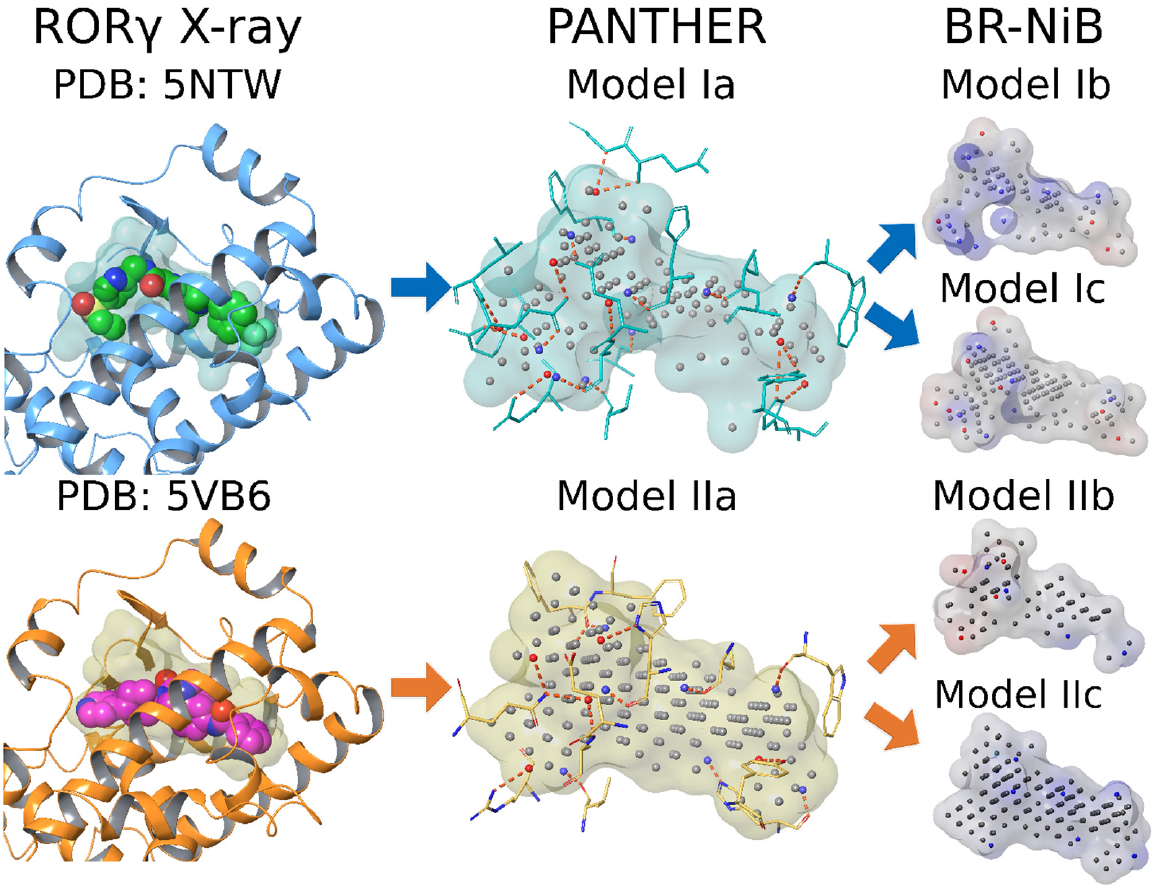
Figure 2. Negative image-based models of the ROR γ t binding cavity. The original cavity-filling negative image-based (NIB) models, Model Ia (PDB: 5NTW [32], cyan transparent surface) and Model IIa (PDB: 5VB6 [42]; yellow transparent surface), were trimmed with brute force negative image-based optimization (BR-NiB) using the complete set of active ligands from the ChEMBL database yielding Models Ib and IIb, respectively. Alternatively, the models were also optimized using only a subset of the ligands yielding to Models Ic and IIc (transparent surfaces with electrostatic potential). The protein 3D structures (blue/orange cartoon models) used in the NIB model generation with PANTHER are shown in complex with the co-crystallized ligands (CPK models with green/magenta carbons). The NIB models (transparent surfaces) are composed of neutral (C; gray), negatively charged (O; red), and positively charged (N; blue) cavity atoms. The projected H-bonds (orange dotted lines) of these cavity atoms with residues (cyan/orange stick models) lining the binding cavity are shown. Hydrogens are omitted for